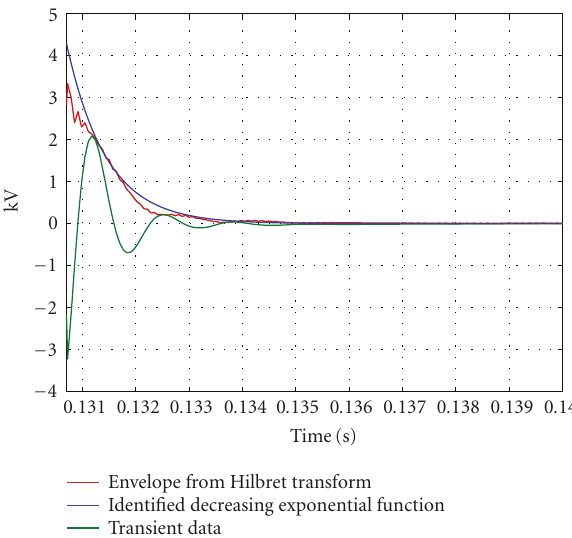
Figure 7: Hilbert damping analysis of phase A transient voltage of a moderately loaded system.